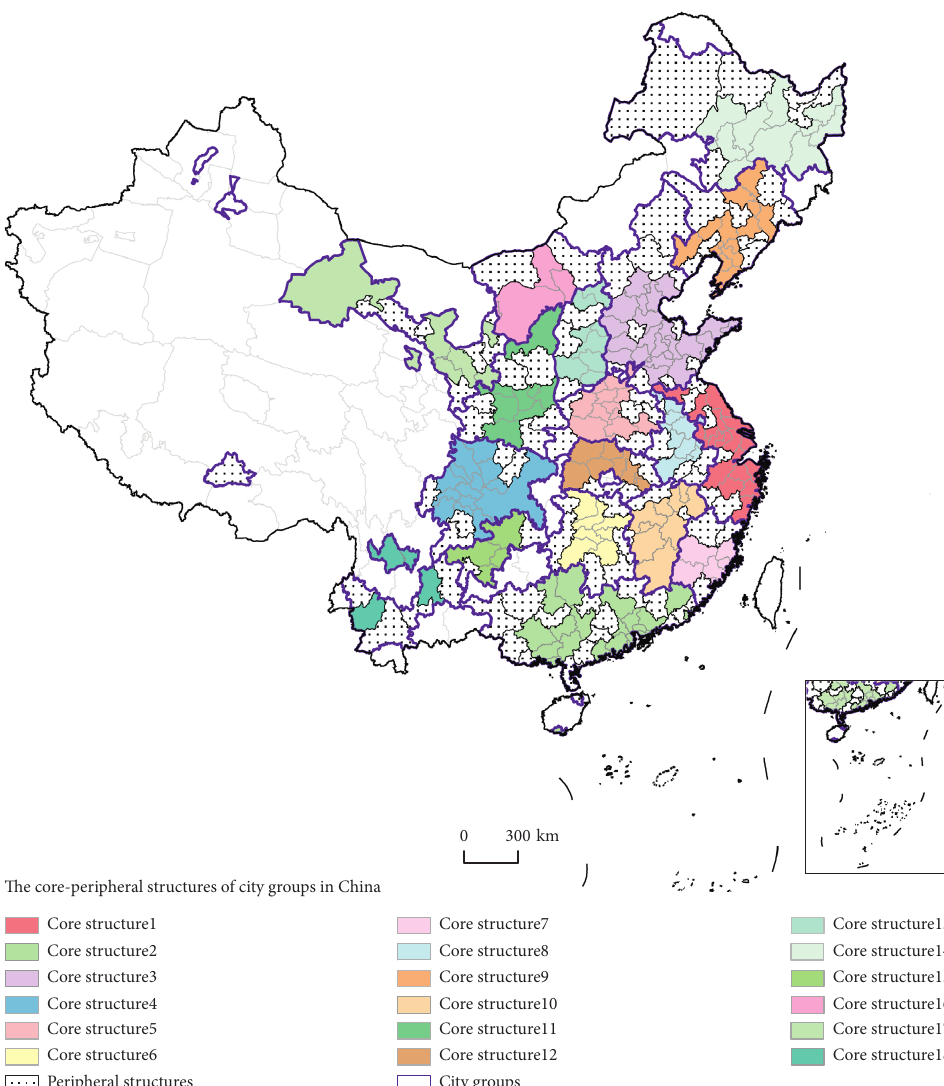
Figure 5: The core and periphery structures of city groups in